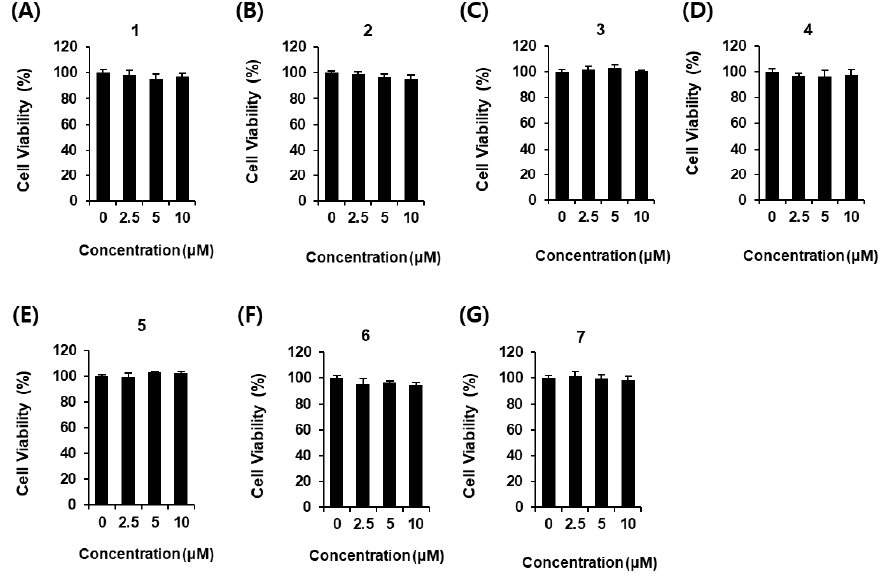
Figure 2. Effects of phenylpropanoids 1 – 7 on the viability of INS-1 cells. Effect of (A – G) com- pounds 1 – 7 compared with the control (0 μM ) on the viability of INS-1 cells for 24 h by MTT assay (n = 3 independent experiments, p < 0.05, Kruskal – Wallis nonparametric test). Data represent the mean ± SEM.